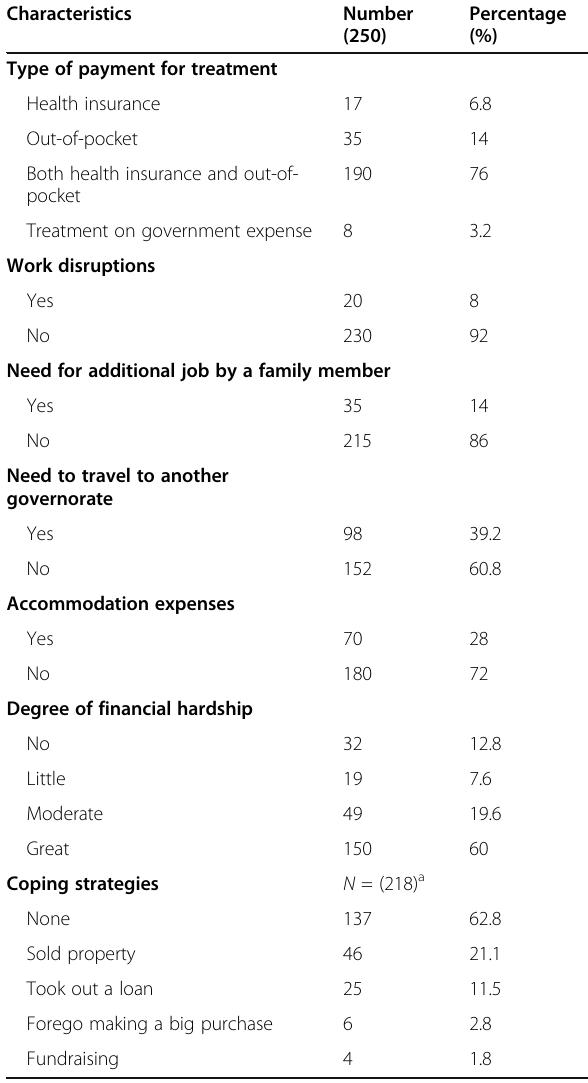
Table 2 Economic impact of CKD on families of affected children, Assiut, Upper Egypt, 2018